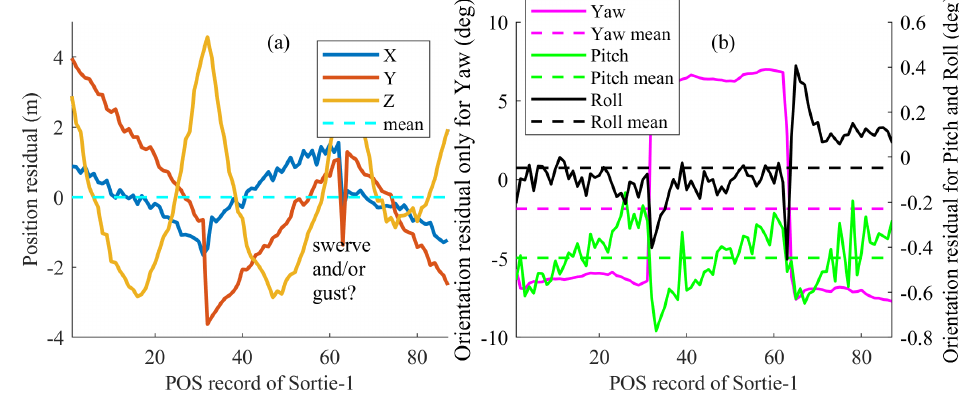
Figure 7. The position and orientation system (POS) residuals after alignment optimization. Sortie-1 is selected here as an example; for the residual distributions of all three sorties, please refer to Figure 8 for their distributions. ( a ) The positional residuals in the photo acquisition sequence. Note that the error accumulates quickly along the same strip, in particular for the Z dimension, which oscillates periodically. ( b ) The orientational residuals in photo acquisition sequence. Note the error of the yaw (left Y -axis) is an order larger than that of pitch and roll (right Y -axis), and the fluctuation amplitude of yaw is much larger as well. In contrast to the mean of positional residual converging to zero, the means of orientational residual are more or less biased.